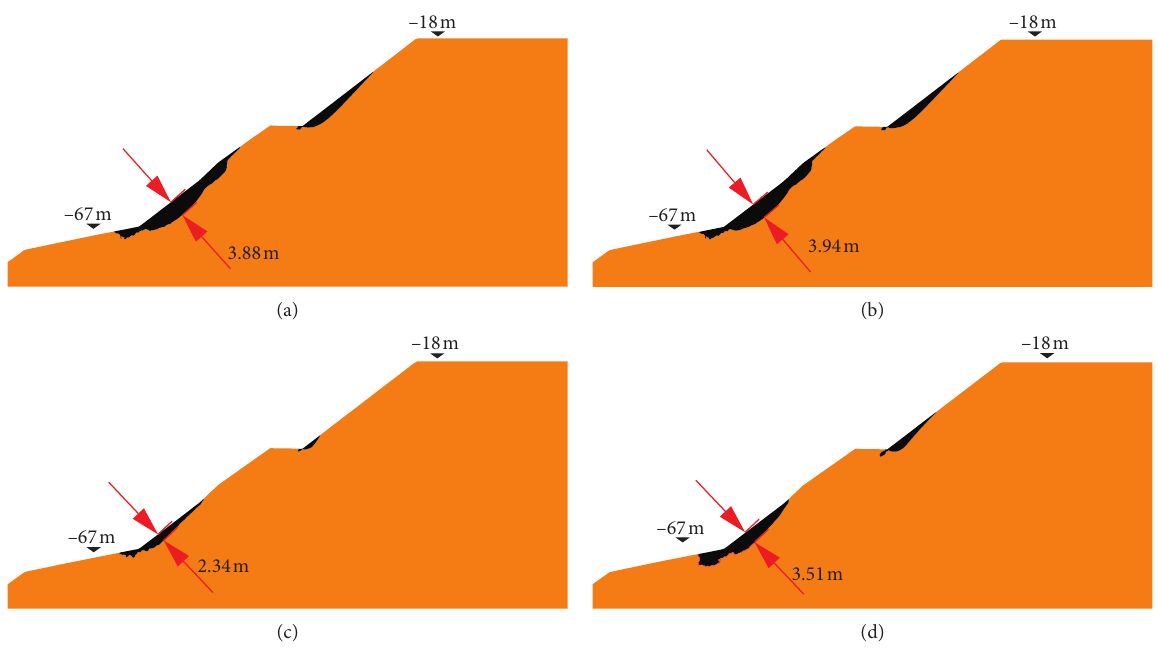
Figure 13: Damage zone of the slope based on four criteria. (a) LEE. (b) NLEE. (c) Pariseau ( n � 1). (d)